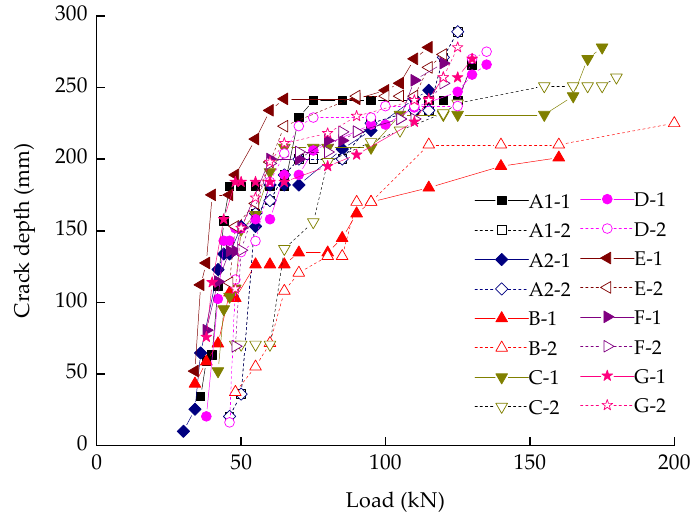
Figure 7. The relation between load and crack depth.